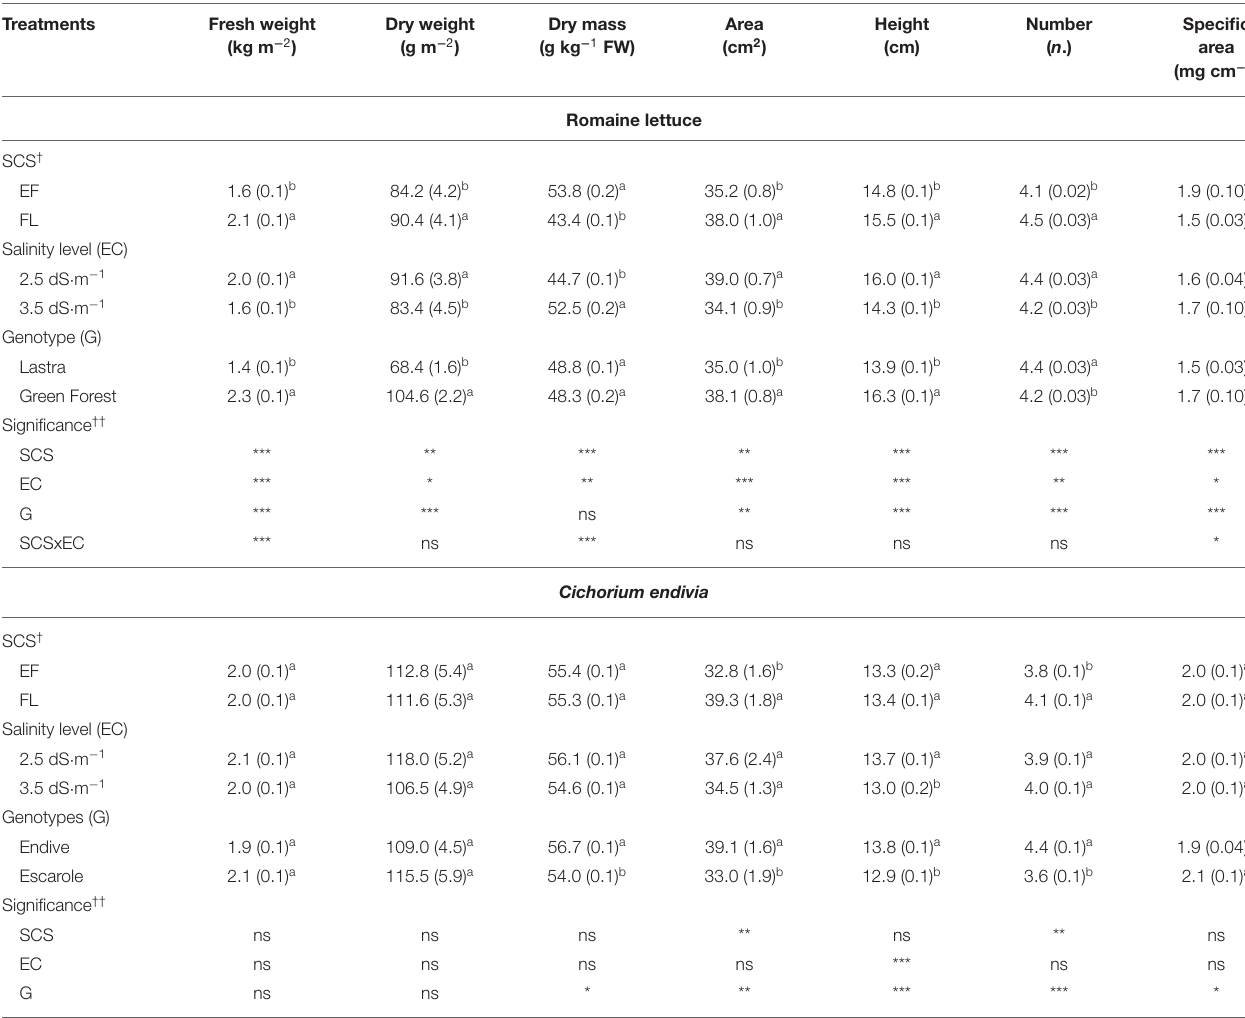
TABLE 2 | Effect of soilless cultivation system (SCS), salinity level of nutrient solution (EC), and genotype (G) on yield and bio-morphological traits of romaine lettuce (autumn cycle) and C. endivia (winter cycle) leaves, with the standard error of the mean in brackets. Treatments